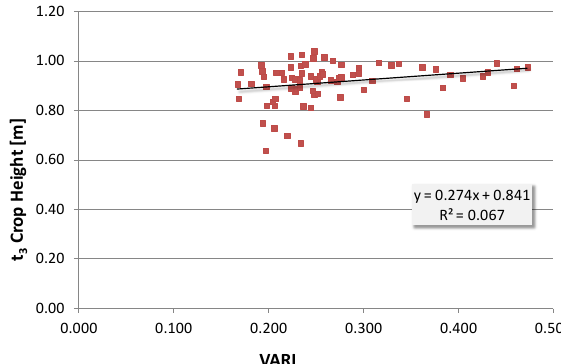
Figure 12. Correlation between vegetation index VARI and crop height for winter wheat trial, measured 2. July 2013 The reason can be seen in the special fertilization experiments in which the influence of potassium and sulfur fertilization should be tested for yield and plant development in general. Potassium and sulfur deficiency symptoms show up only at the end of the growing season and become visible to the human eye.